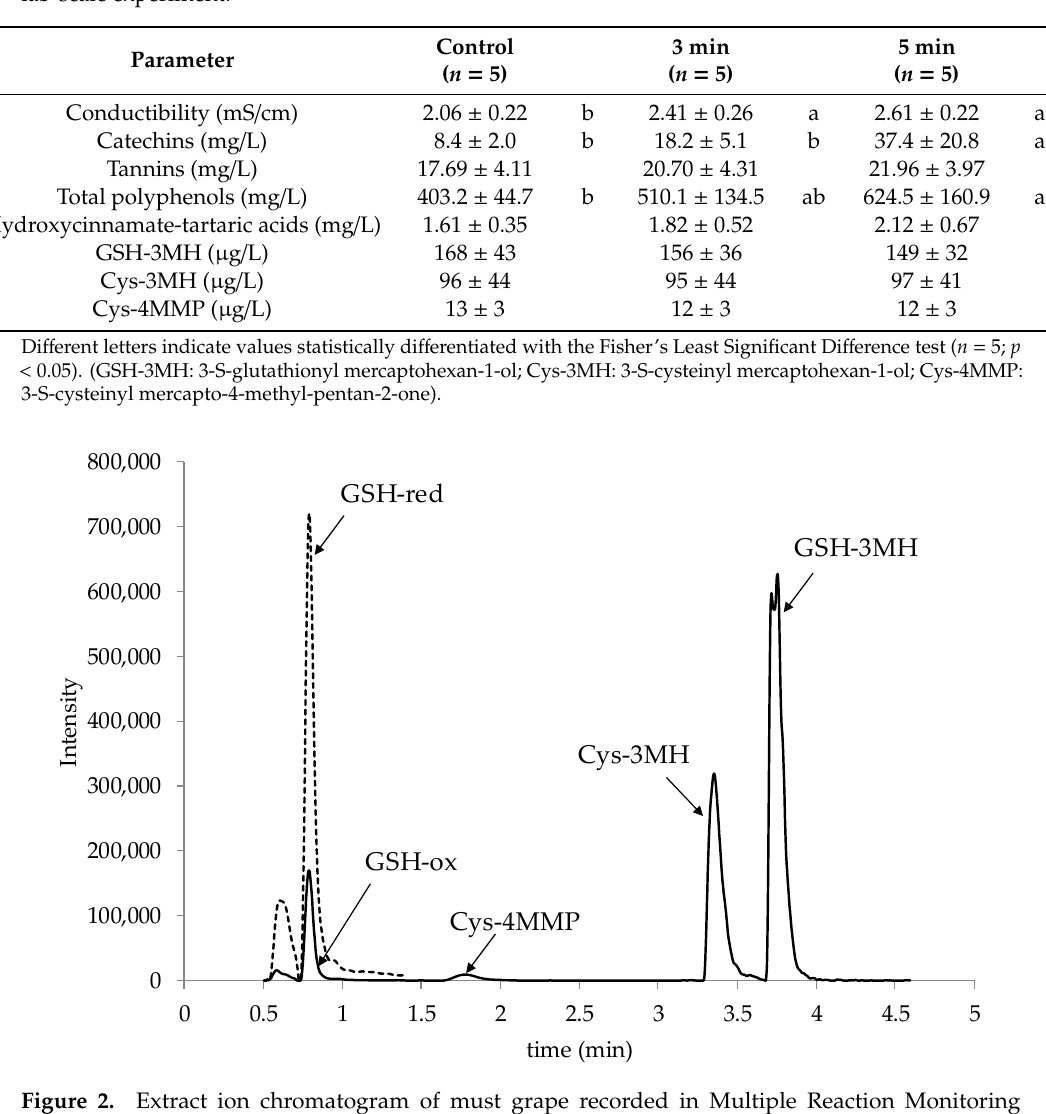
Figure 2. Extract ion chromatogram of must grape recorded in Multiple Reaction Monitoring (MRM) mode.